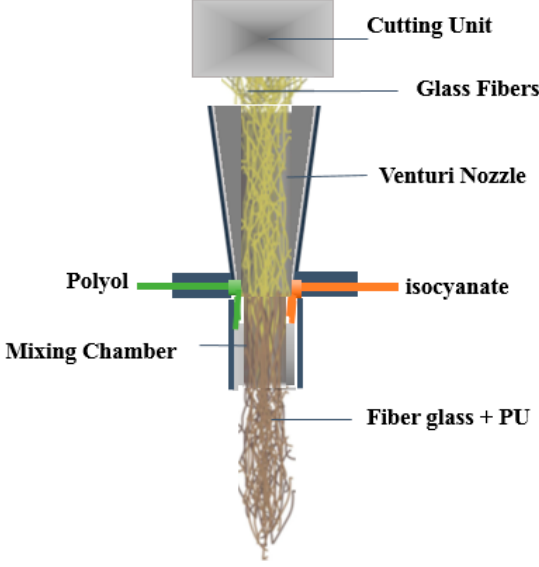
Figure 1. Long Fiber Injection (LFI) mixing head, Internal mixing of fiberglass and Polyurethane components in mixing chamber before injection [15].